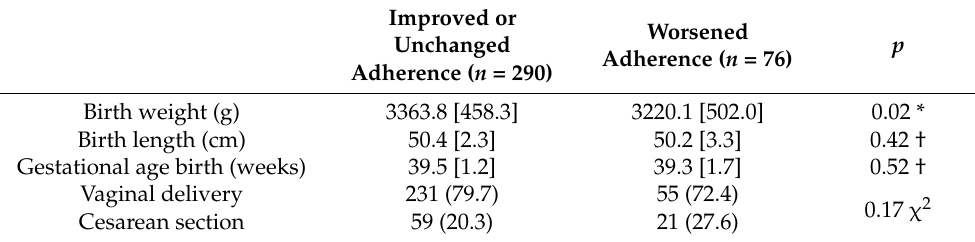
Table 3. Correlations between MD adherence and neonatal and obstetrics outcomes.